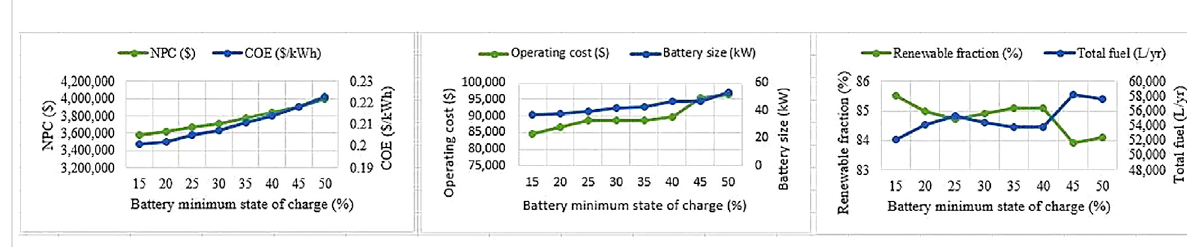
FIGURE 14 Effect of battery minimum state of charge variation on the selected dependent variables.